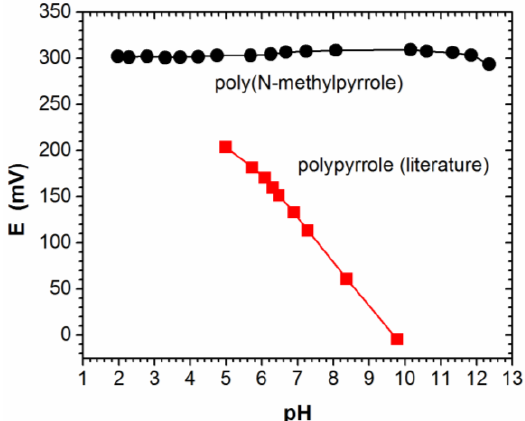
Figure 4. Effect of pH on response of nitrate ISE’s using polypyrrole and poly( N -methylpyrrole) films. Poly( N -methylpyrrole) is relatively insensitive to pH. Polypyrrole data are taken from [11].